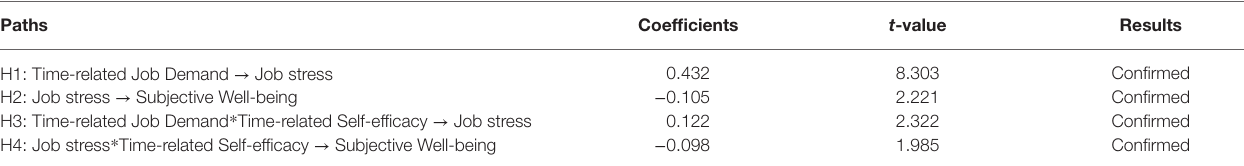
TABLE 3 | Results of hypotheses testing.